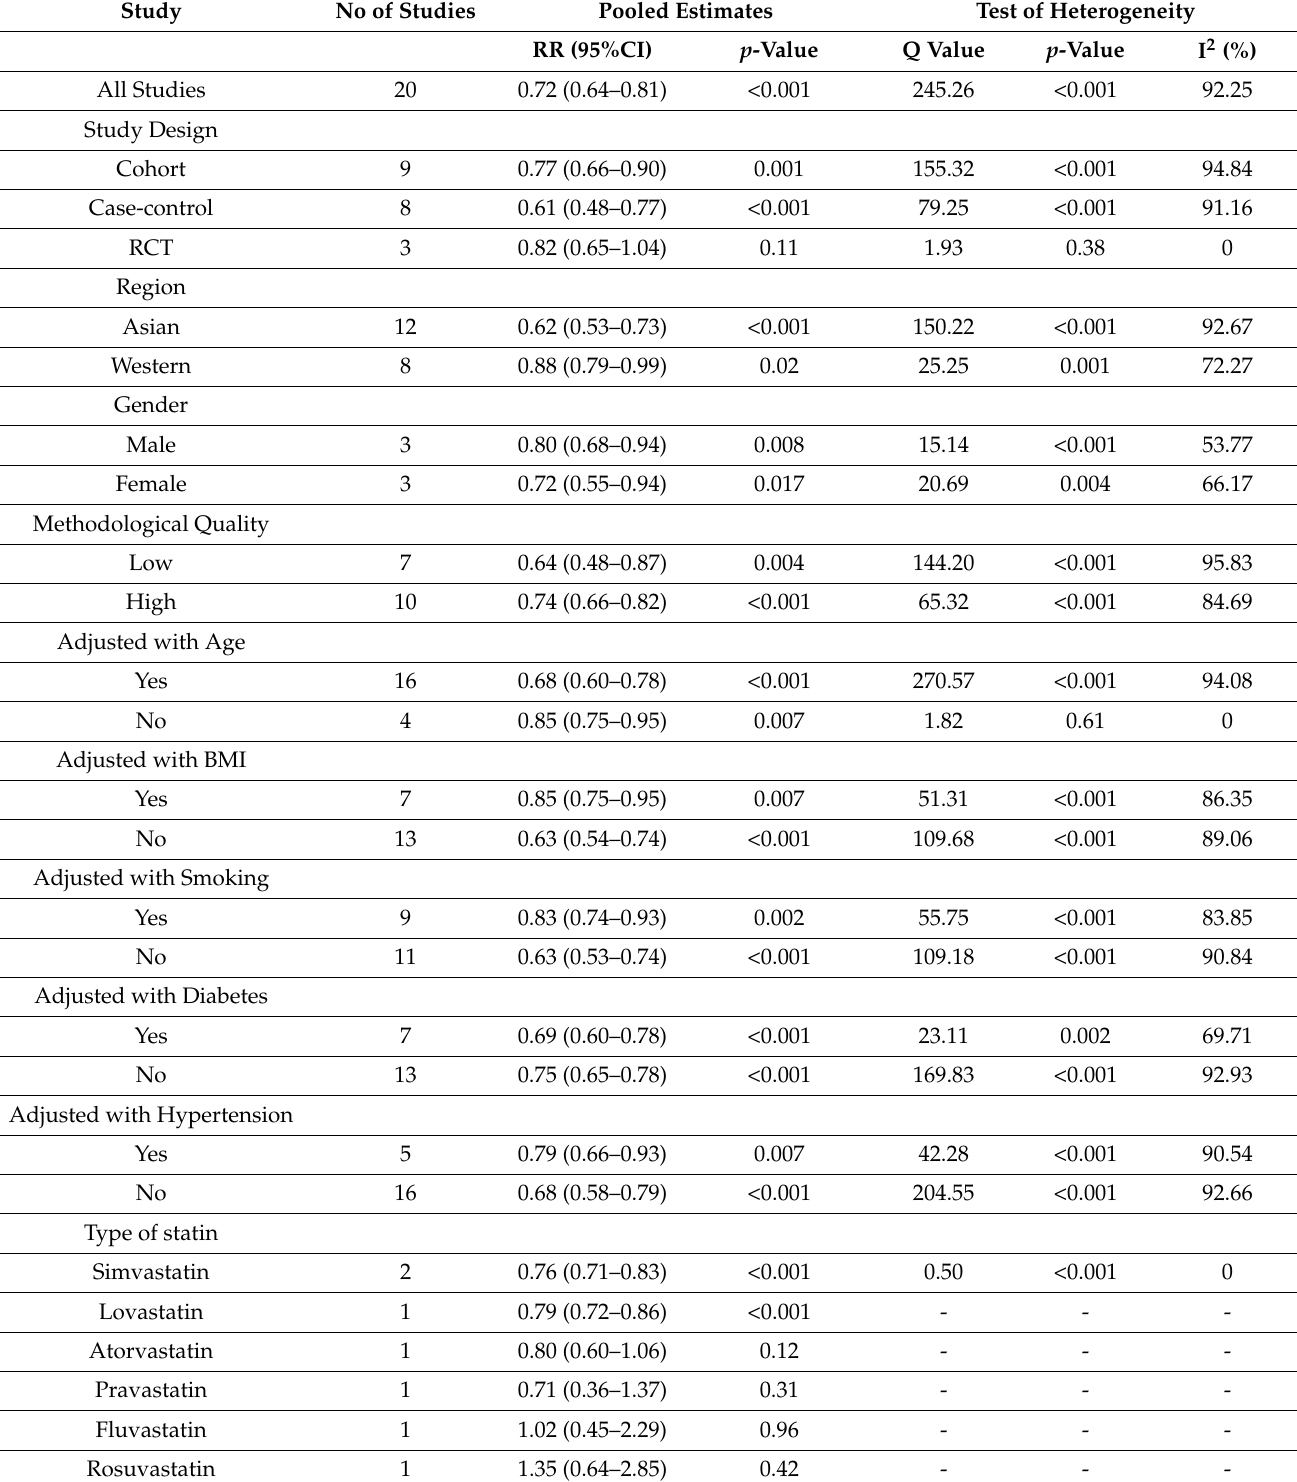
Table 2. Subgroup analyses for the association between statin use and risk of gastric